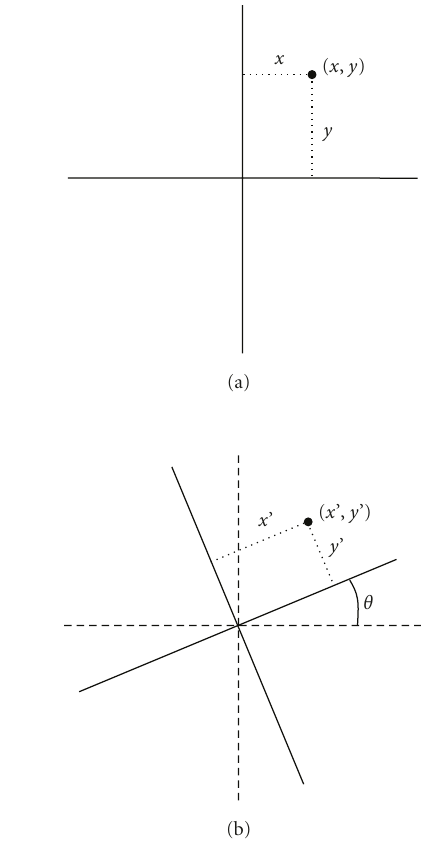
Figure 4: (a) ( x , y ), the original coordinates of a pixel. (b) ( x (cid:3) , y (cid:3) ), the rotated coordinates of the pixel by the estimated edge angle θ